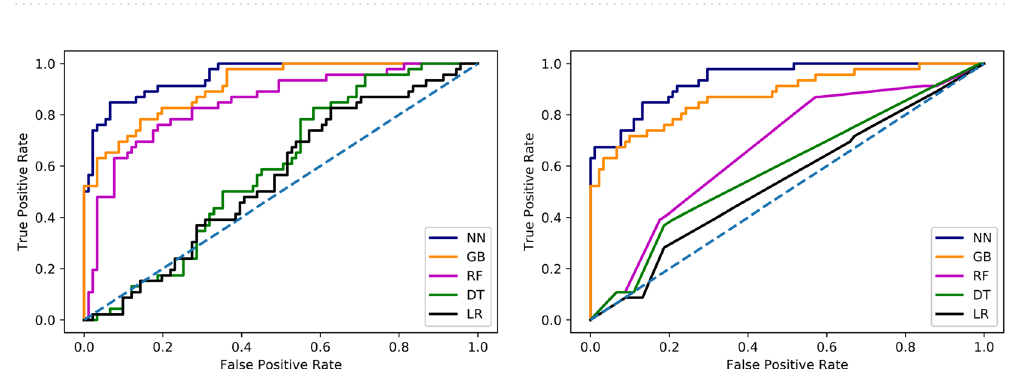
Table 3. Detailed results of machine learning classifiers for prediction of mortality and post-surgery prolonged LOS.